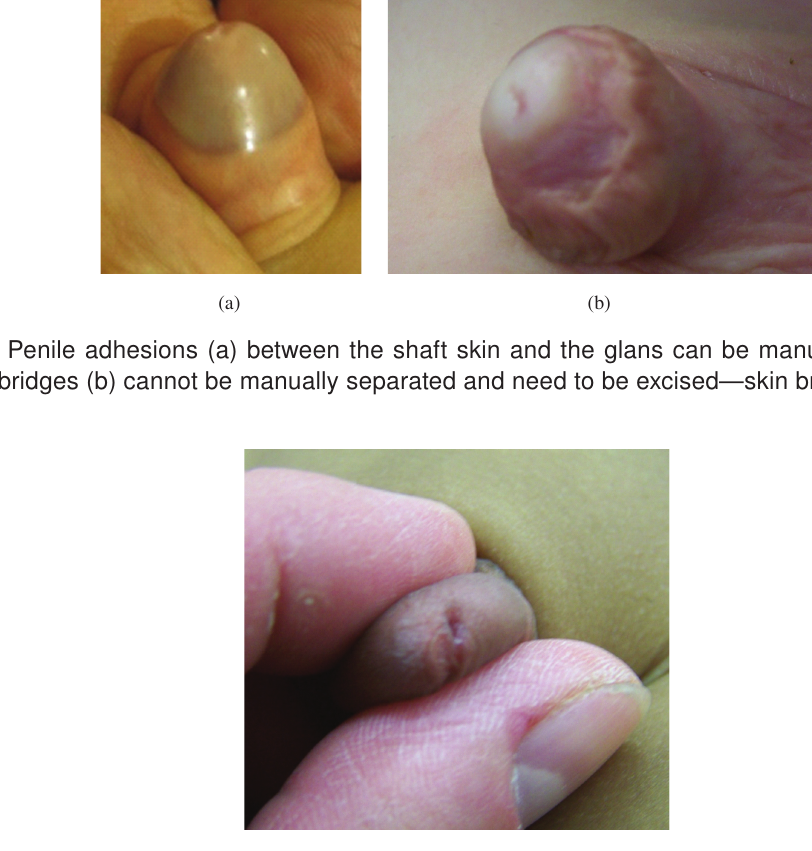
FIGURE 8: Meatal stenosis in a 3 year old circumcised male who presented with a narrow